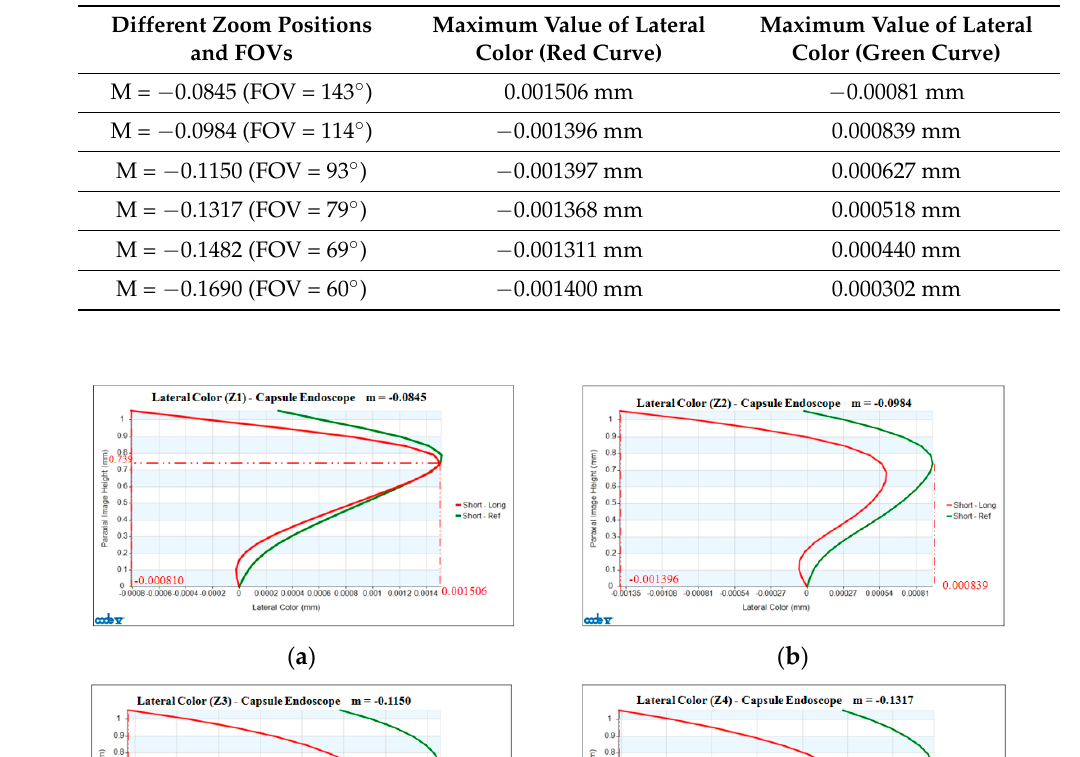
Table 4. Comparison of lateral chromatic aberrations at different magnification positions.